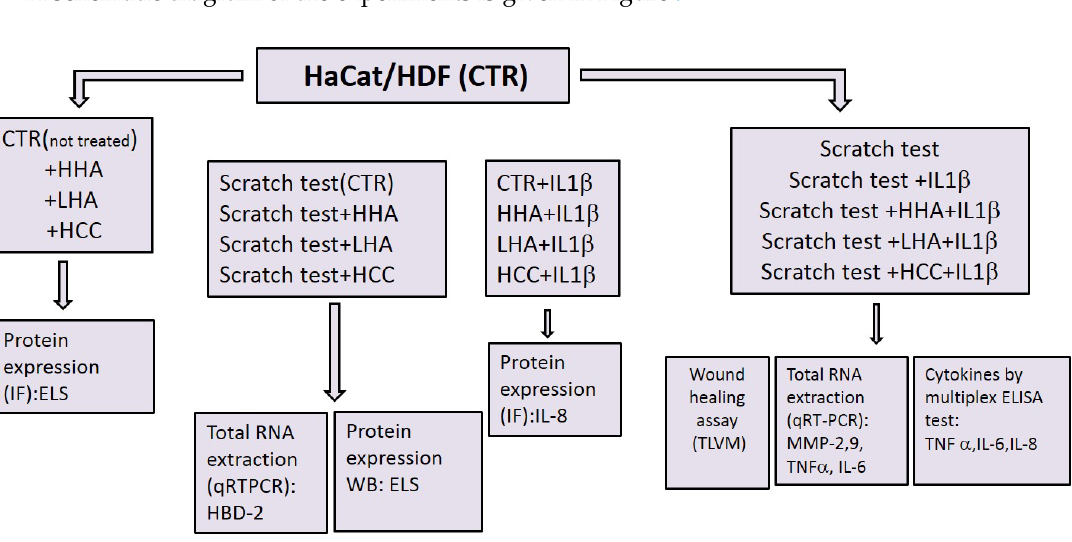
Figure 9. Schematic diagram that shows the experiment set up. (ImmunoFluorescence (IF), Western Blotting (WB), Elastin (ELS), Enzyme-Linked Immunosorbent Assay (ELISA), Time Lapse Videomicroscopy (TLVM), quantitative Real Time Polymerase Chain Reaction